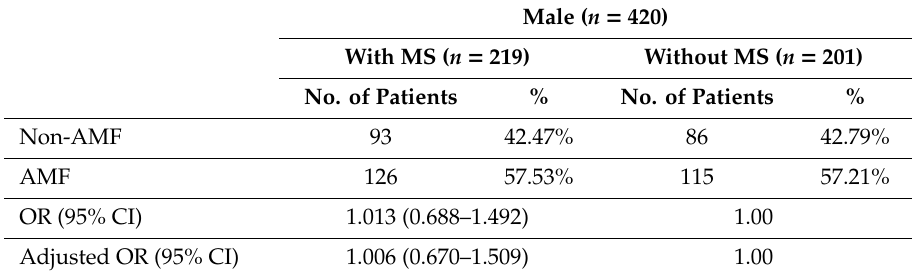
Table 4. Odds ratio for males with a diagnosis of multiple sclerosis with amalgam fillings. Male ( n = 420) With MS ( n = 219) Without MS ( n =